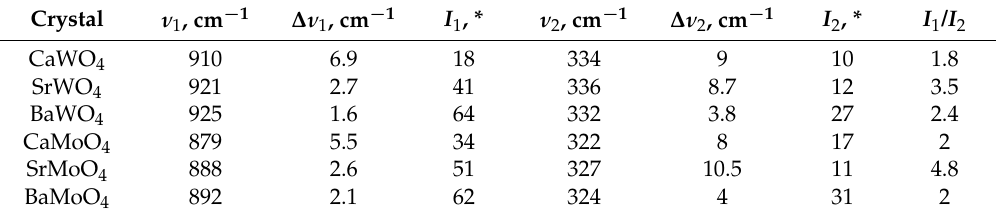
Table 1. Spontaneous Raman scattering parameters of alkali-earth tungstate and molybdate crystals in E (cid:107) c